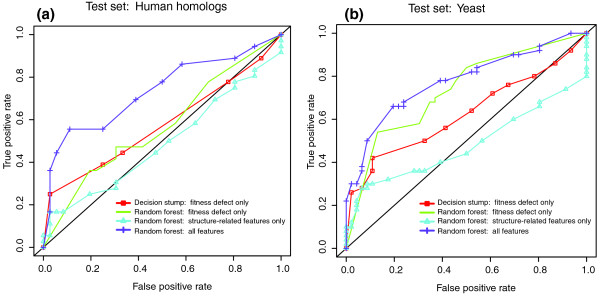
Drug target prediction accuracy (ten-fold cross validation) using one of four algorithms: log2 ratio fitness defect with a simple decision stump model (red); log2 ratio fitness defect with a richer random forest model (green); the chemical structure similarity features with the random forest model (blue); and all features with the random forest model (purple). Each point represents a threshold for the algorithm. For the decision stump, each point represents a single log2 ratio value, and for the random forest, each point represents the algorithm's decision as a mode of decision trees that use the available features (see Materials and methods). The accuracies of other algorithms are shown in Supplementary Figure 7 in Additional file 1. (a) Performance on the expert-curated reference set of compounds and their known interacting yeast proteins. (b) Performance on DrugBank protein-compound interactions (mostly human) mapped to yeast through protein homology.